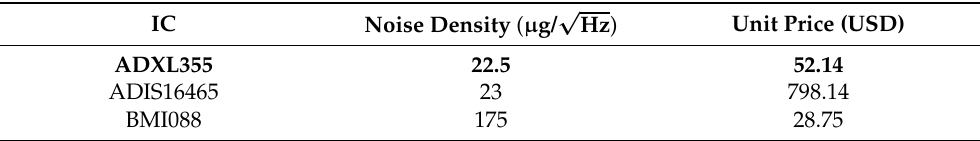
Table 2. Accelerometer noise density prices for different sensor ICs. IC